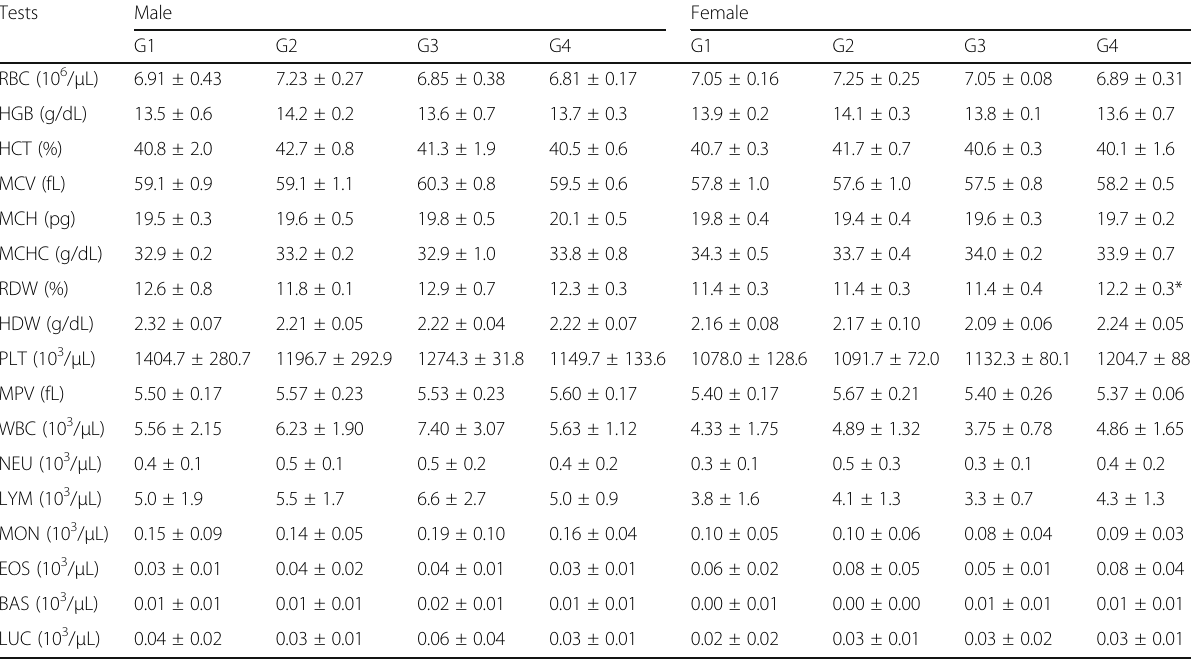
Table 3 Effect of oral administration of OE on hematological parameters